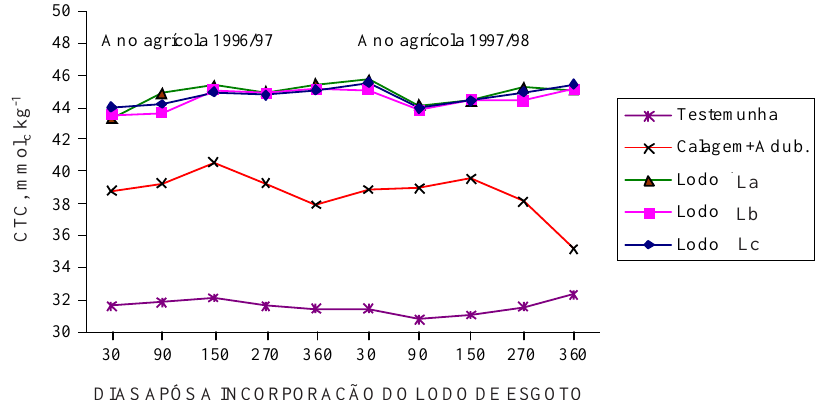
Figura 2. Capacidade de troca de cátions do solo, nos anos agrícolas 1996/97 e 1997/98, para os tratamentos com doses de lodo de esgoto e calagem + adubação